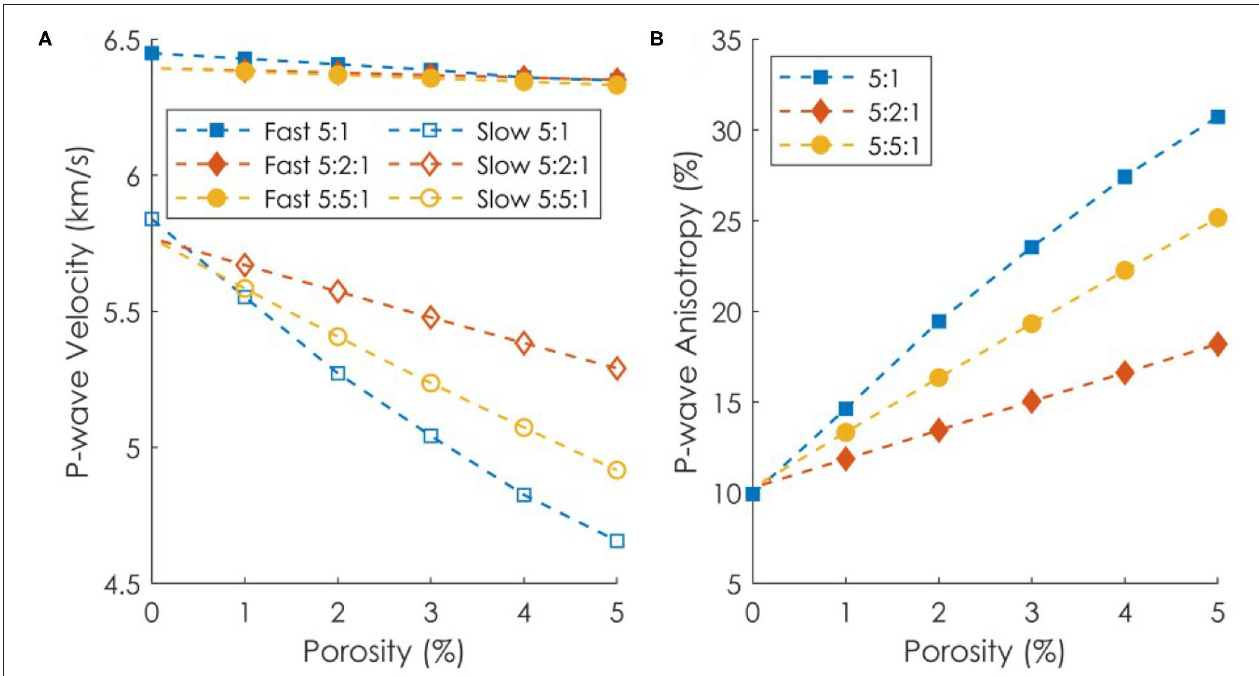
FIGURE 10 | Comparison between (A) modeled P-wave velocities and (B) P-wave anisotropy of the three rock models with three different pore aspect ratios: 5:1 (2D), 5:2:1 (3D), and 5:5:1